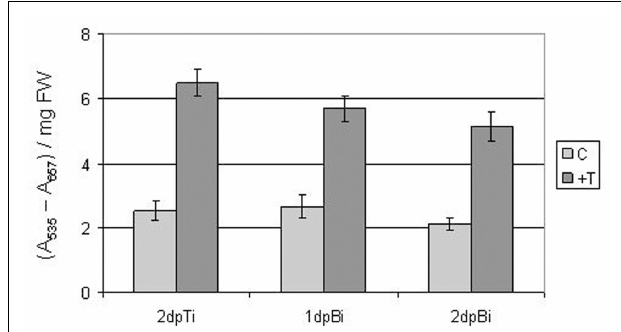
FIGURE 5 | Quantification of anthocyanin levels (expressed as corrected A 535 per milligram fresh weight) in ISR-primed and mock-treated control plants at 2days post-treatment with T. hamatum T382 (dpTi) and in ISR-boosted and Botrytis inoculated control plants at 1 and 2days post-inoculation with B. cinerea (dpBi). The values are means ± SE of six measurements of four plants each. FW, fresh